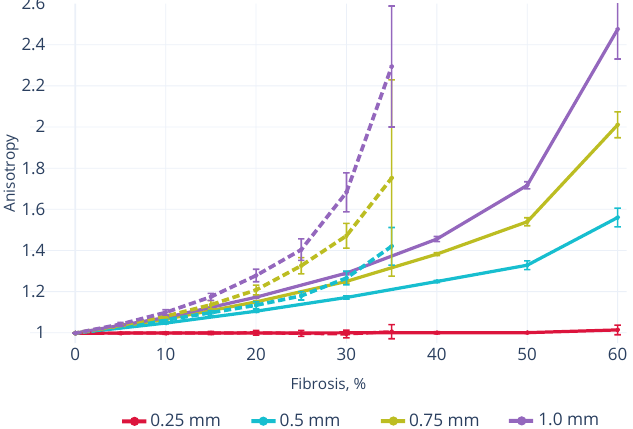
Figure 5. Ratio in the conduction velocity between the longitudinal and transversal wavefront direction as a characteristic of the fibrotic texture anisotropy. Dotted lines show the ratio in the monolayer models, solid lines—in the multilayer models. Error bars show STD for the same model groups as in Figure